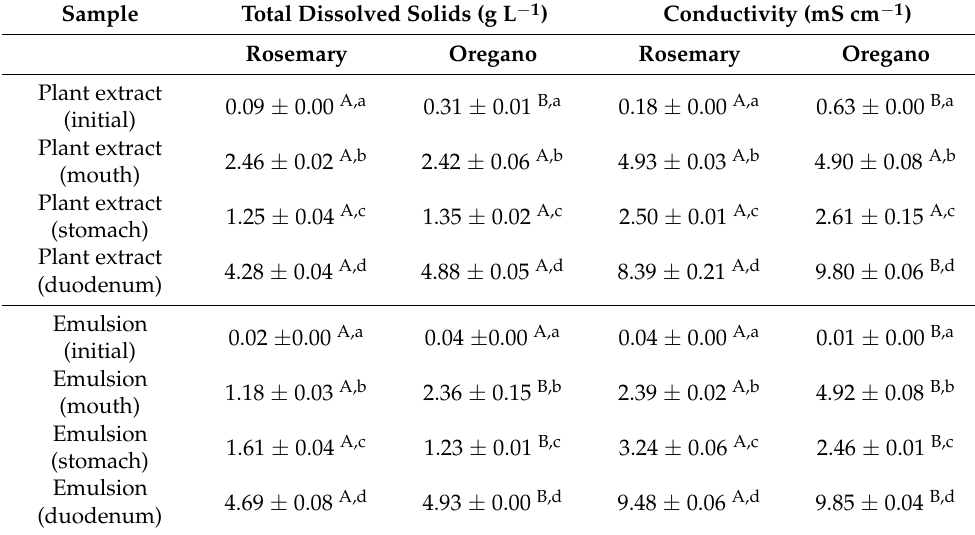
Table 5. Physical properties of rosemary/oregano extracts and oil-in-water emulsions containing rosemary/oregano extract, with the addition of commercial pea protein as emulsifier, before and during in vitro digestion. A,B The same superscript capital letters within a row denote no significant differences ( p > 0.05) between the values obtained for the different plant aqueous extracts and emul- sions at the same experimental conditions according to Tukey’s ANOVA. a–d The same superscript lowercase letters within a column denote no significant differences ( p > 0.05) between values during in vitro digestion according to Tukey’s